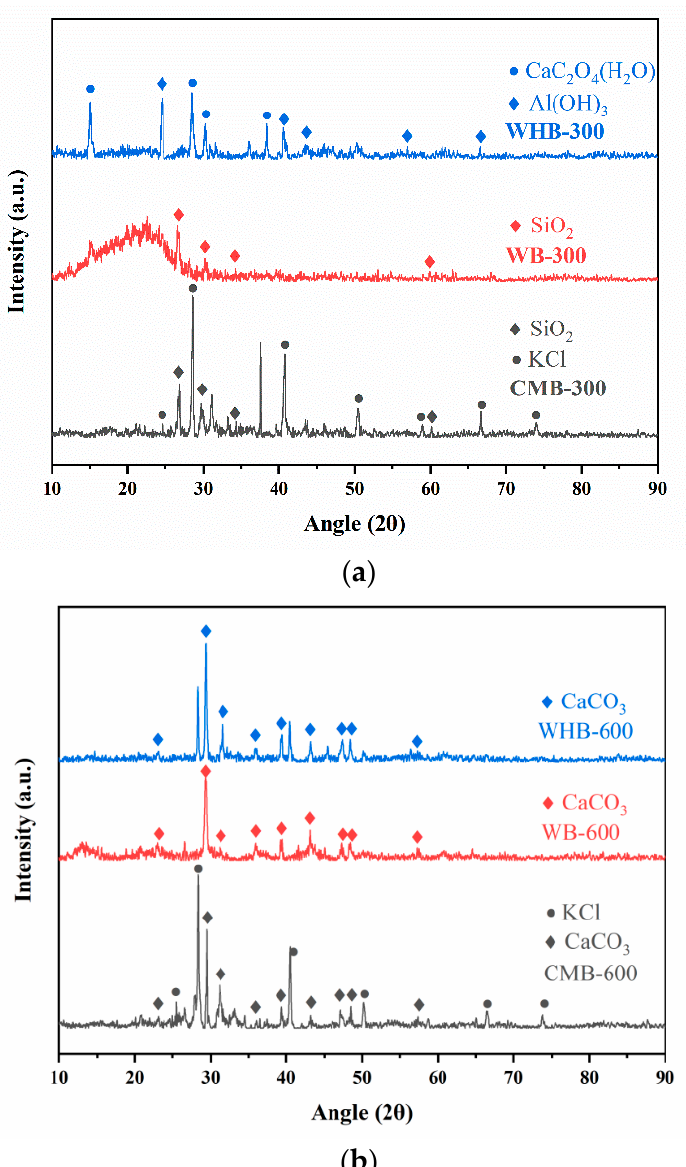
Figure 5. ( a ) XRD results for all biochar samples at 300 °C. ( b ) XRD results for all biochar samples at 600 °C.